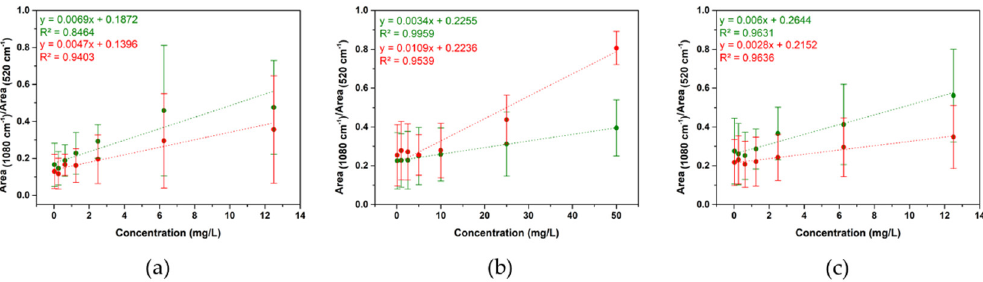
Figure 5. Calibration curve of ( a ) PVP-15nmAg NPs, ( b ) PVP-50–80nmAg NPs, and ( c ) PVP-100nmAg NPs detection in ultrapure water (green line) and artificial seawater (red line).